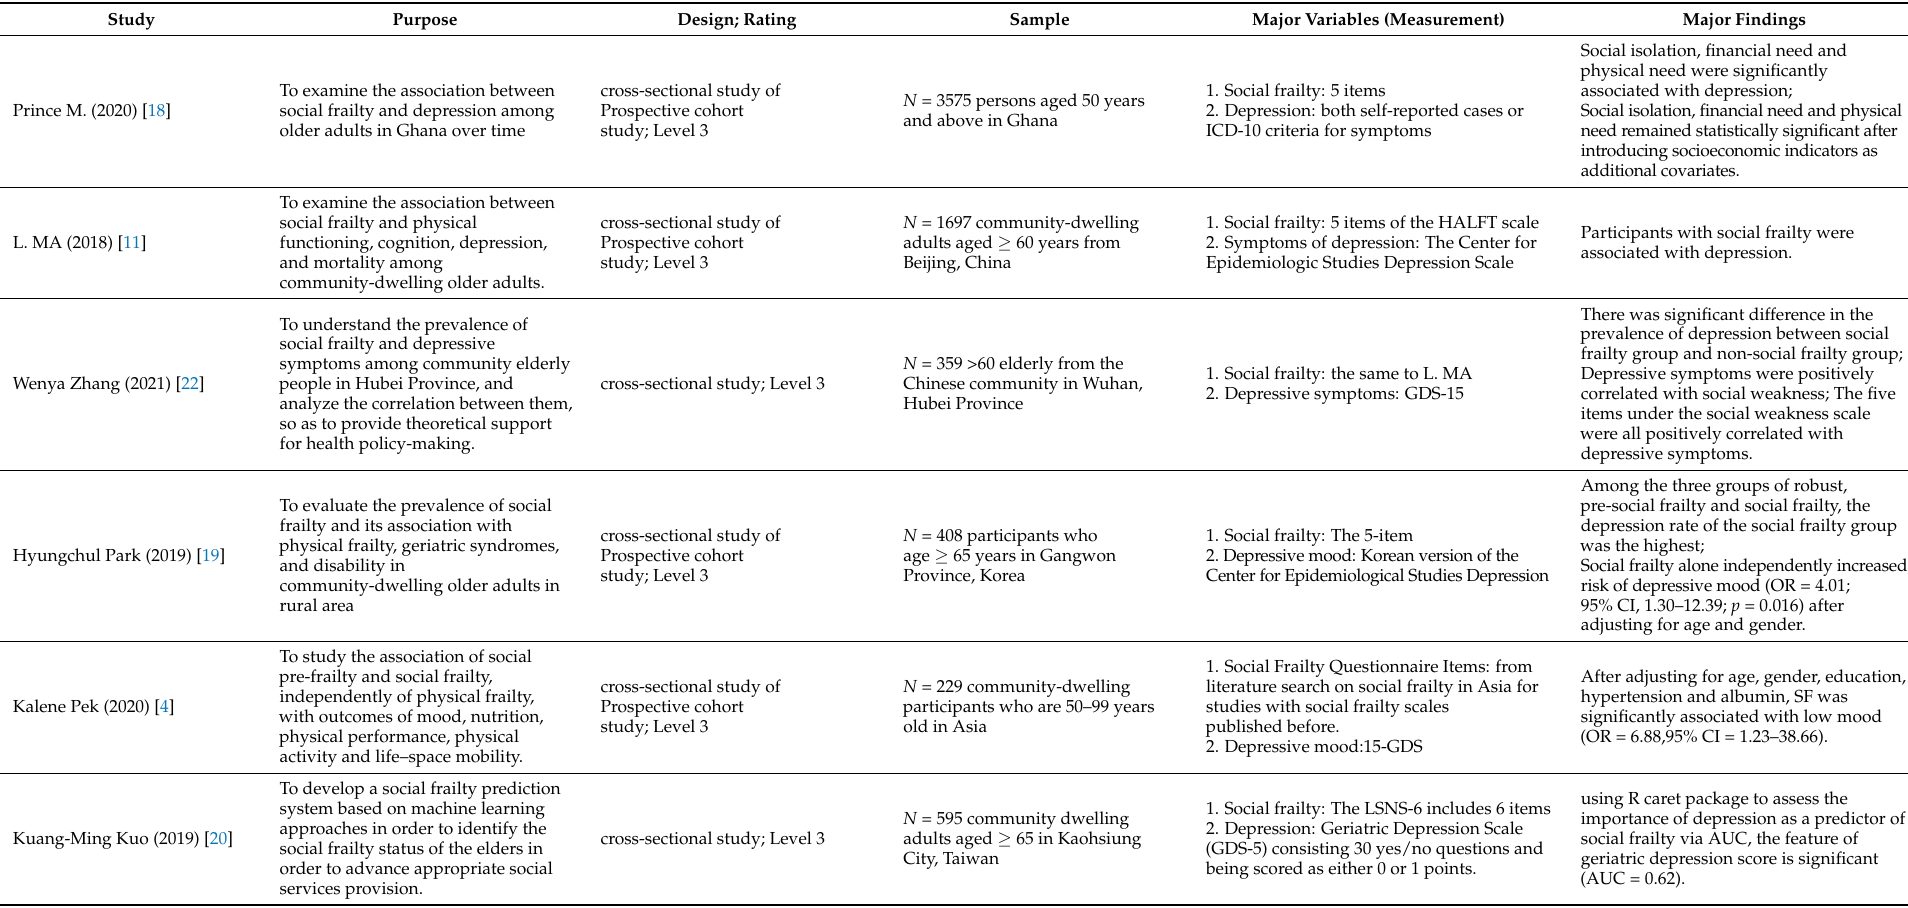
Table A2. Summary of data extraction from the cross-sectional